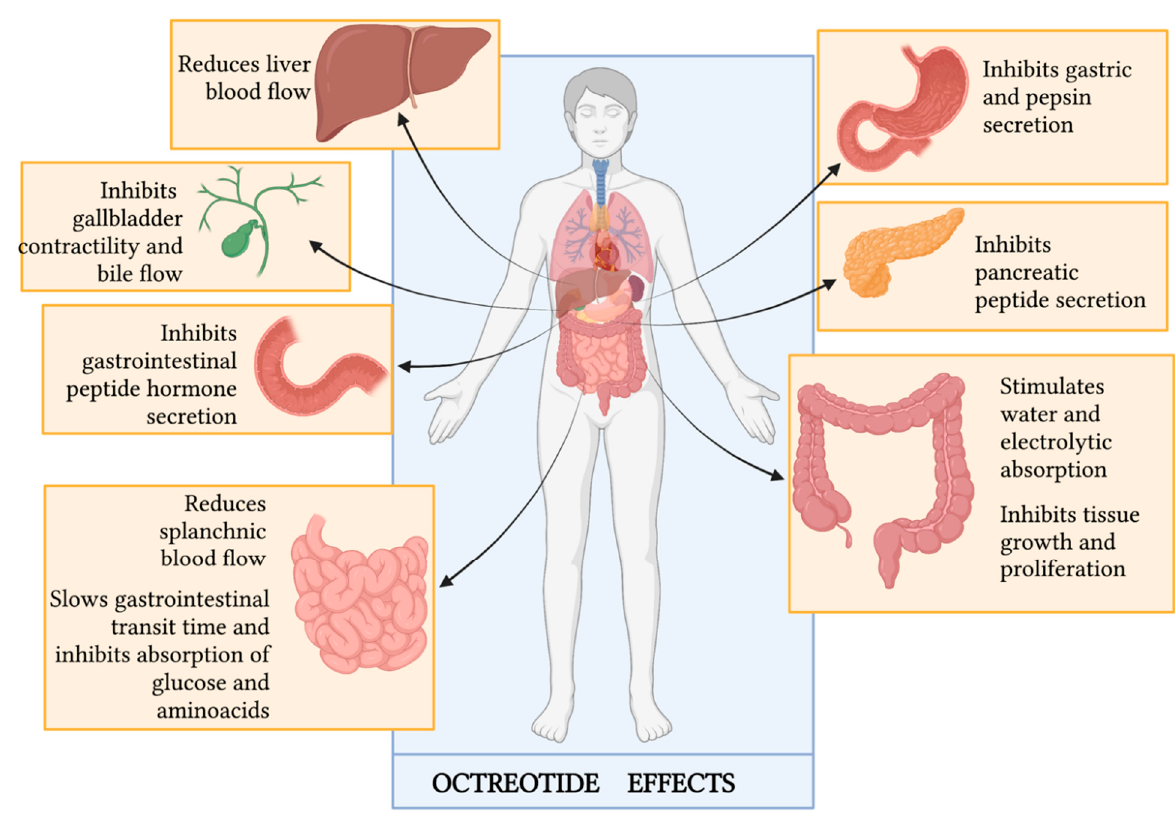
Figure 3. Octreotide clinical effects (Figure adapted by Lamberts SW, van der Lely AJ, de Herder WW, Hofland LJ. Octreotide [35]).